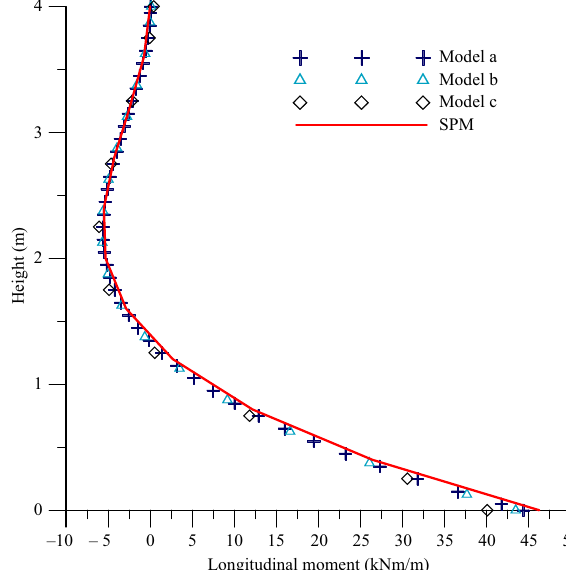
Fig. 8. Longitudinal moments for FEM models and SPM (Ex.2)